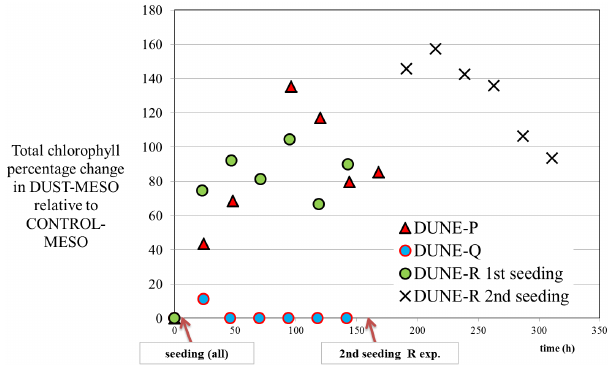
Fig. 11. Comparison of the changes in chlorophyll a (relative differ- ence between average DUST and average CONTROL mesocosms, mean of concentrations at 0, 5 and 10m) observed in P, Q and R experiments as a function of time after each